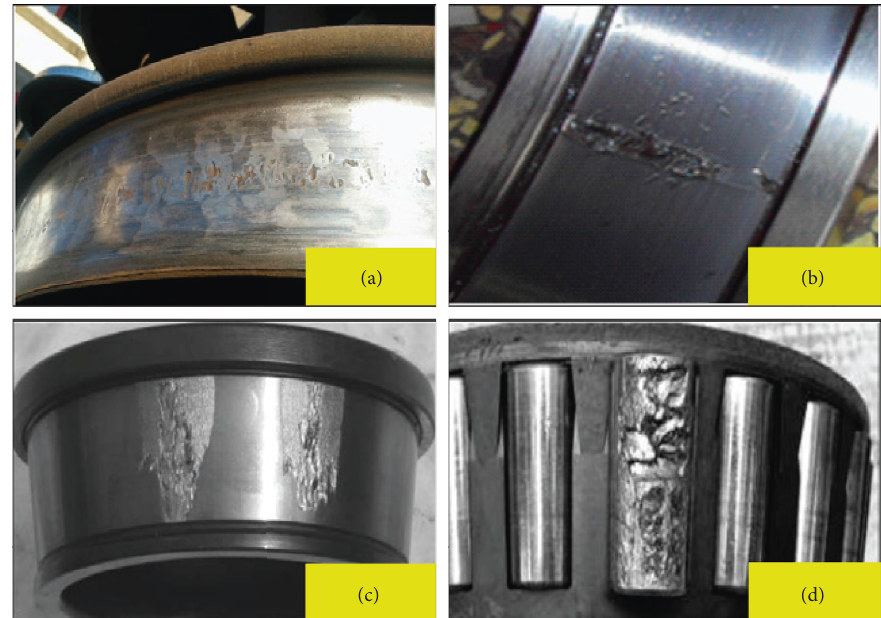
Figure 1: Common localized faults of wheel tread and axle box bearing: (a) failure on wheel tread; (b) failure on the outer race of bearing; (c) failure on the inner race of bearing; (d) failure on the ball of